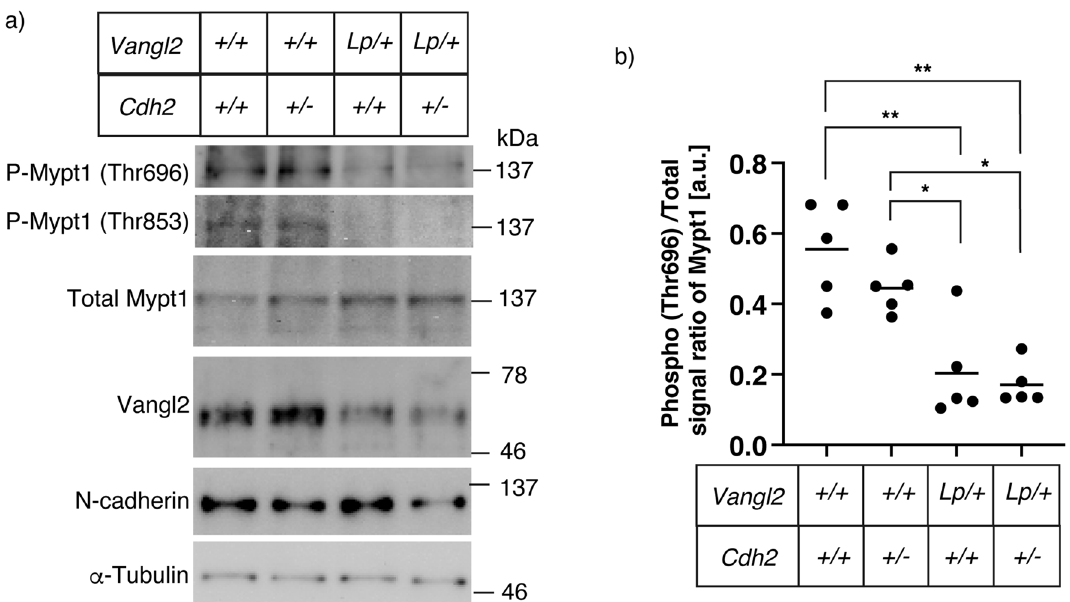
Figure 4. RhoA/ROCK signaling activity in the neural tube. ( a ) Western blot analysis of the neural tube cell lysates derived from E9.5 embryos with the indicated genotypes. Total and phospho-epitopes of Mypt1, the downstream of RhoA/ROCK pathway, were analyzed. ( b ) Point graph showing Thr696 phosphorylation levels of Mypt1. The ratios were calculated according to the signal strength of anti-phosphorylated Mypt1 and that of anti-total Mypt1. The phospho-levels were not significantly different between Vangl2 Lp/+ ; Cdh2 + / + and Vangl2 Lp/+ ; Cdh2 + /− embryos, although the levels for both embryos were lower than those of the wild type or Vangl2 + / + ; Cdh2 + /− embryos. The solid line indicates the mean of each genotype (n = 5). Significant differences between groups were calculated using Tukey’s multiple comparison test (* P < 0.05 or ** P <